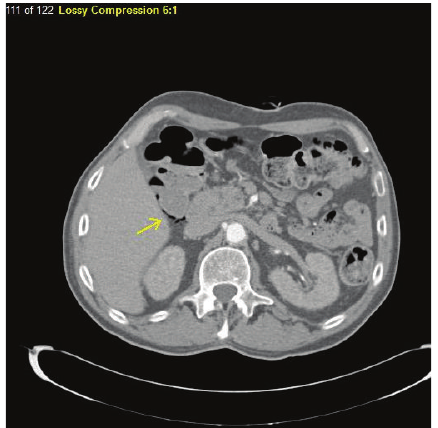
Figure 2: A CT image of dependent air in the bowel wall of Patient 1.